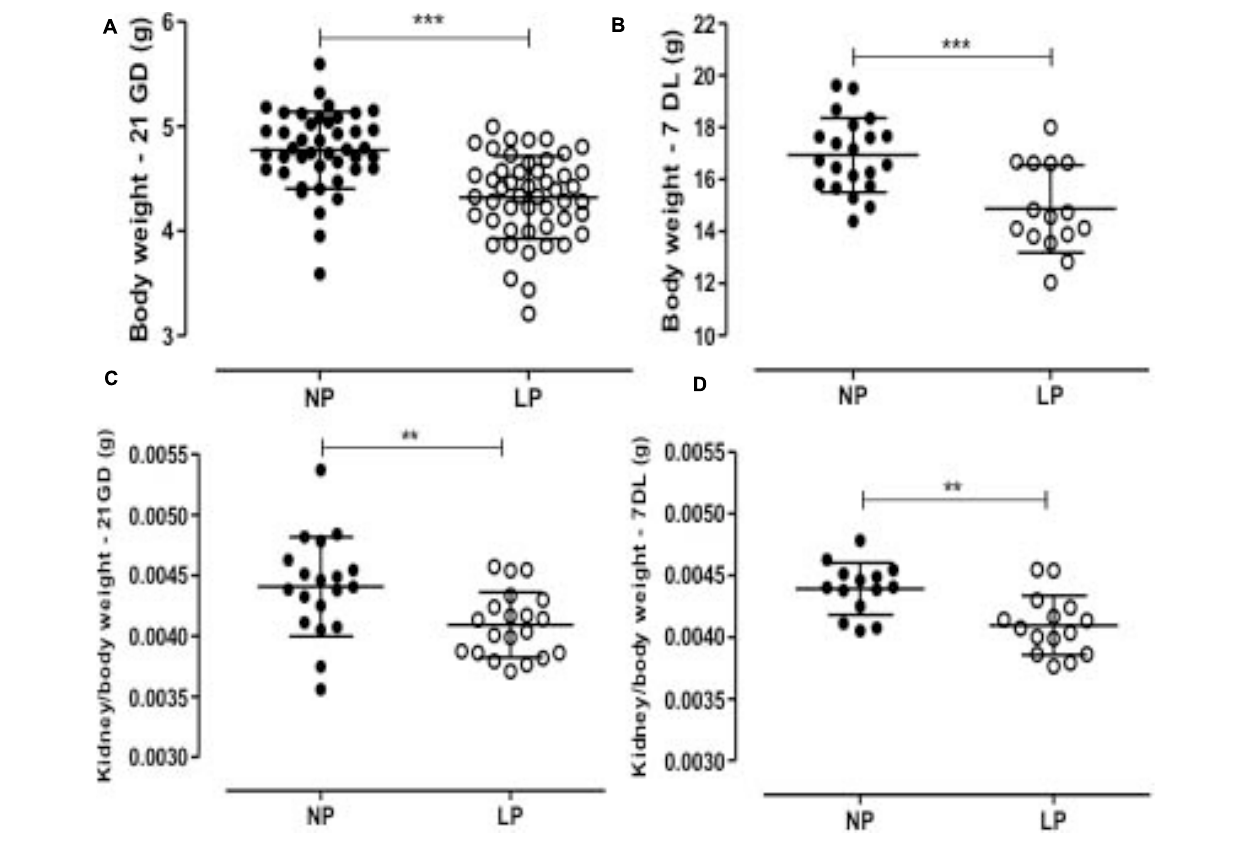
FIGURE 1 | The graphics represent the male pups’ weight of body ( A : 21GD, B :7DL) and kidney/body ( C : 21GD, D :7DL). Mean ± SD, ** p < 0.005 and *** p < 0.0001.